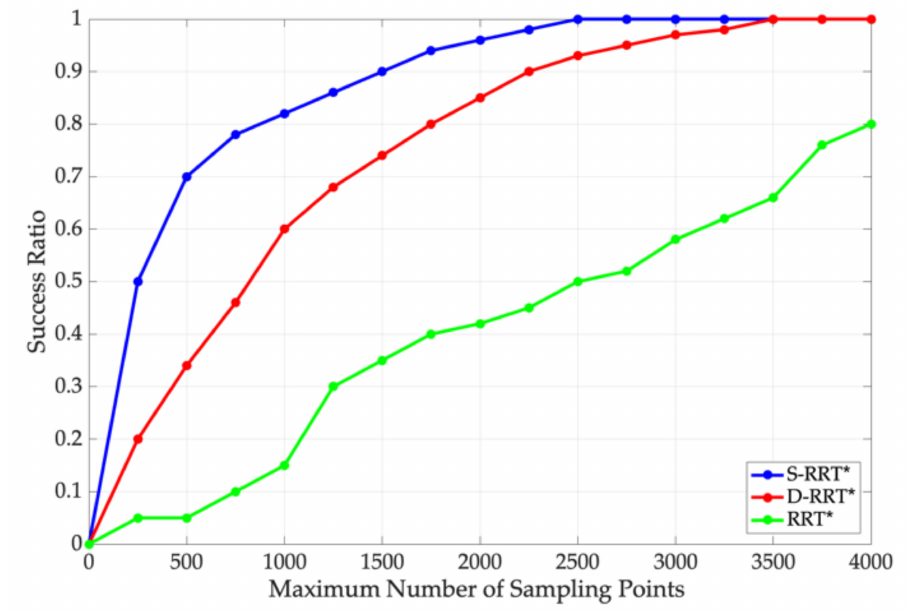
Figure 9. Success ratios of RRT*, S-RRT*, and D-RRT*. The minimum numbers of sampling points and the total running times of the three algorithms are specified in Table 4 for the aforementioned path